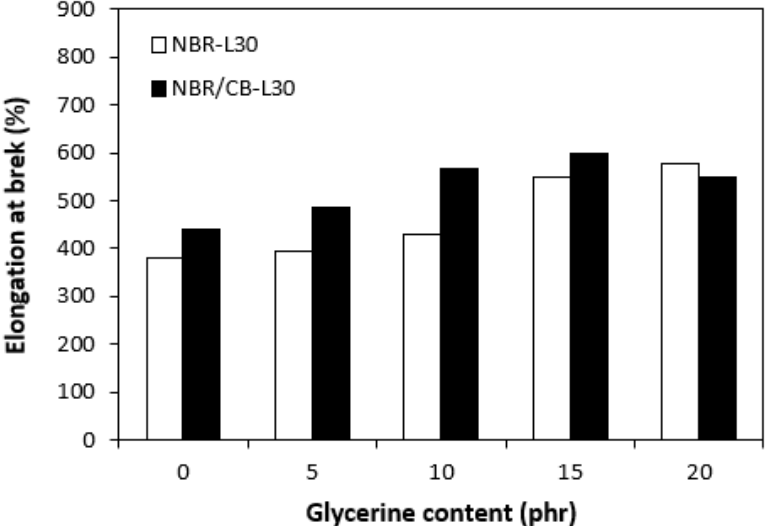
Figure 14. Influences of glycerine contents on modulus M300 of vulcanizates.